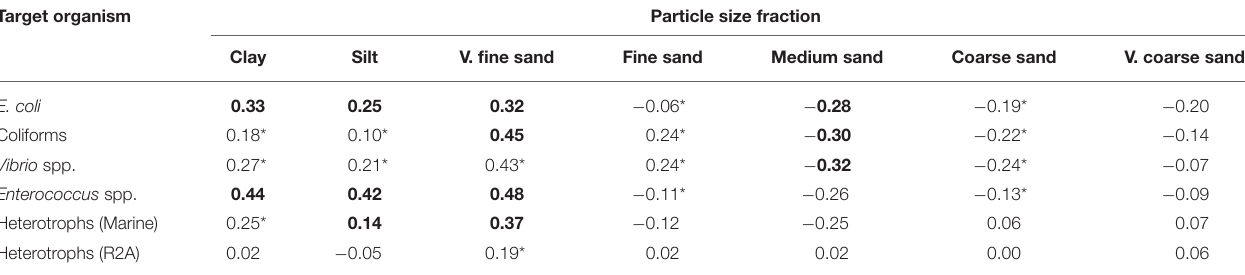
TABLE 3 | Spearman’s rank correlations of different culturable bacterial groups with sediment particle size fractions. Target organism